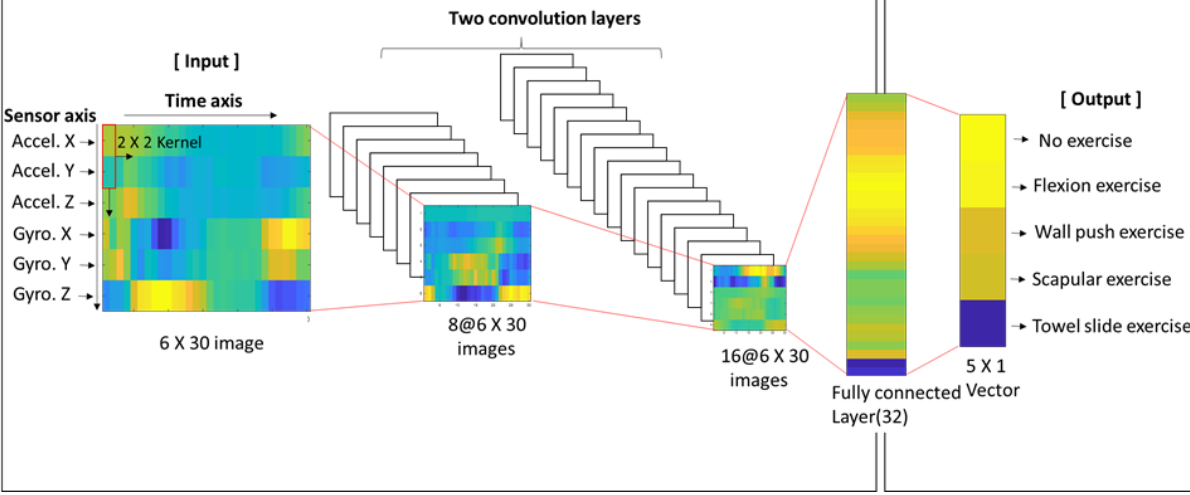
Figure 3 reflects our baseline CNN architecture. Two convolution layers, which have 8 and 16 feature maps, are followed by a fully connected layer that has 32 nodes. Rectified units are employed as activation functions, and SoftMax functions are used for evaluating the final five output node